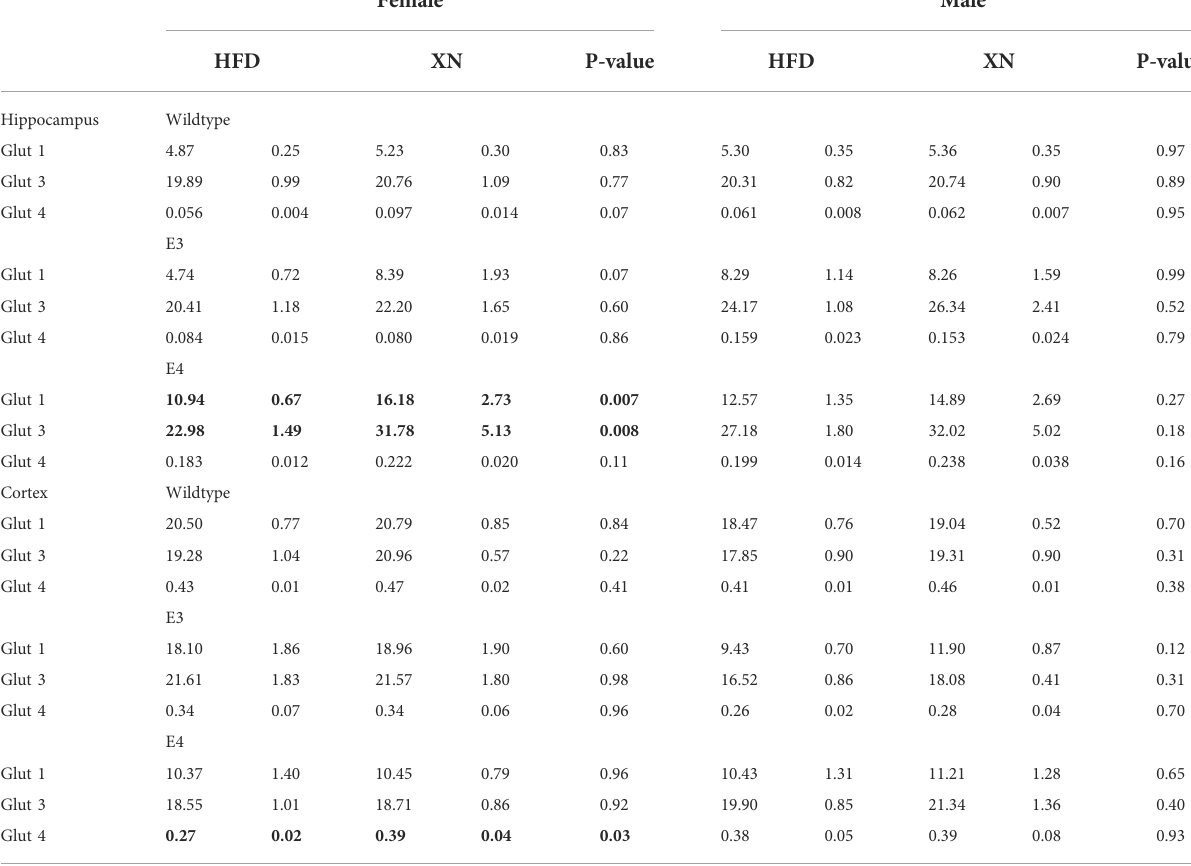
TABLE 2 Glucose transporter protein levels (in ng/mg protein) affected by XN in the hippocampus and cortex in the standard exposure